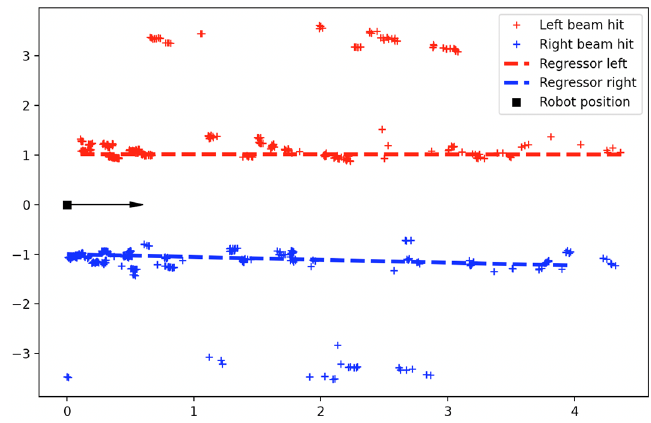
Figure 5. Vineyard row detection using a LiDAR scan.